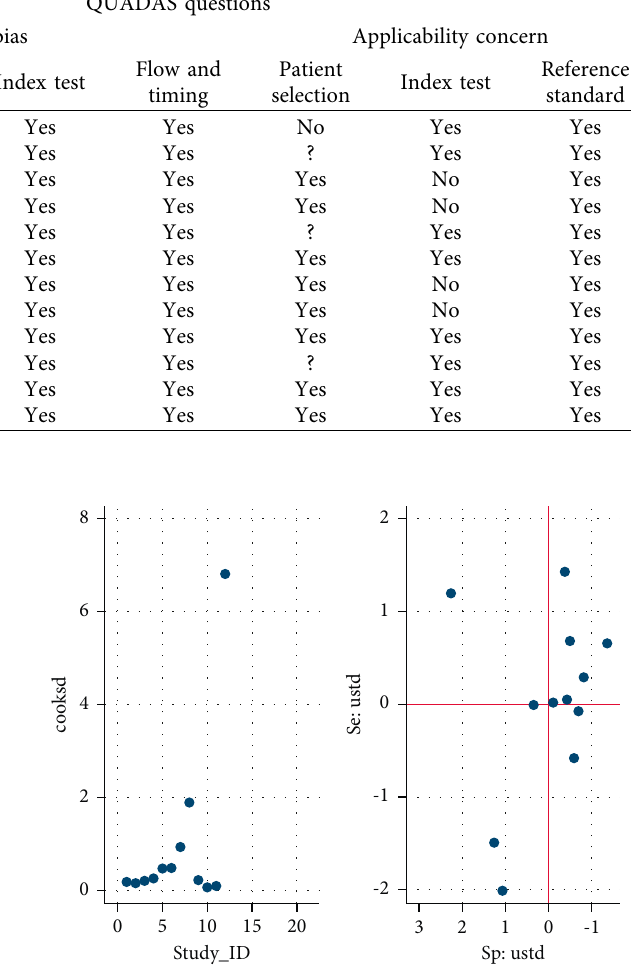
Figure 3: Left panel: Cook’s distance. Right panel: standardized residuals (standardized predicted random effects). Table 4: Meta-analysis of accuracy.